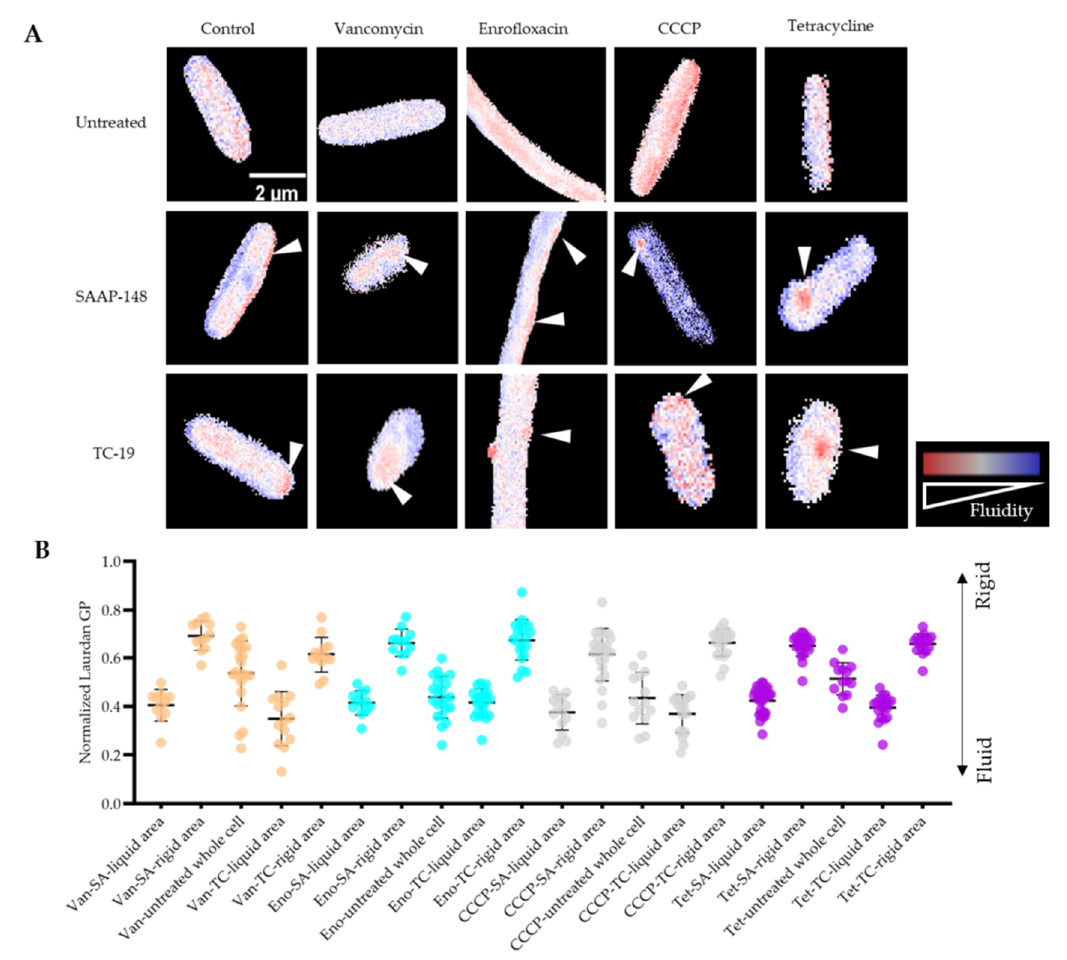
Figure 8. AMPs cause membrane fluidity alterations of persisters. After 5 min SAAP-148/TC-19 exposure, membrane fluidity alteration of persistent and vegetative B. subtilis was indicated by laurdan staining. ( A ) Microscope images showed that AMPs exposure created fluidity patch (red, white arrows) on membrane while left parts of membrane became more rigid (blue). ( B ) Average laurdan generalized polarity (GP) of membrane fluidity areas (red) and rigid areas (blue) of persisters resulting from exposure to different stressors was quantified. Compared with the membrane of untreated persisters in each group, fluid area was more fluid ( p < 0.05), and rigid area was more rigid ( p < 0.05). No significant difference in the membrane liquid or rigid level between SAAP-148 and TC-19 treated persisters was observed ( p > 0.05). Van: vancomycin; Eno: enrofloxacin; Tet: tetracycline; SA: SAAP-148; TC: TC-19.